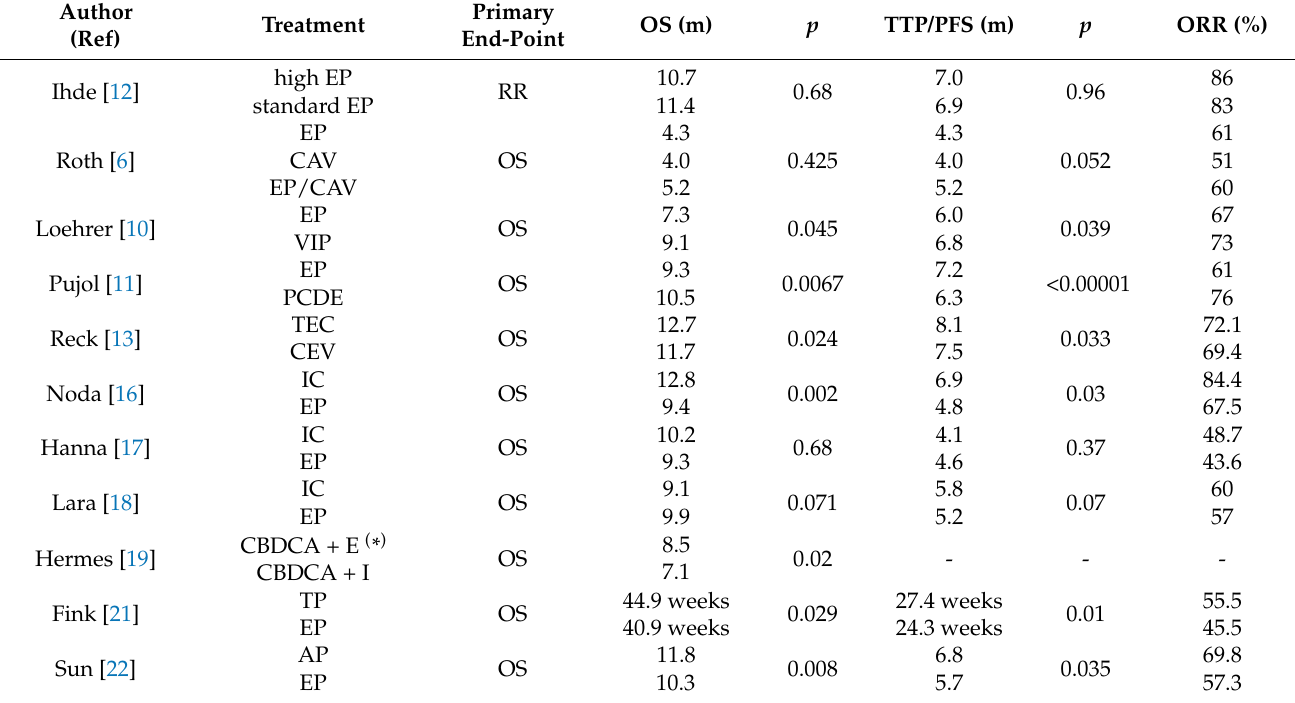
Table 1. Phase III trials exploring chemotherapy in first-line setting of patients wing extensive disease small cell lung cancer